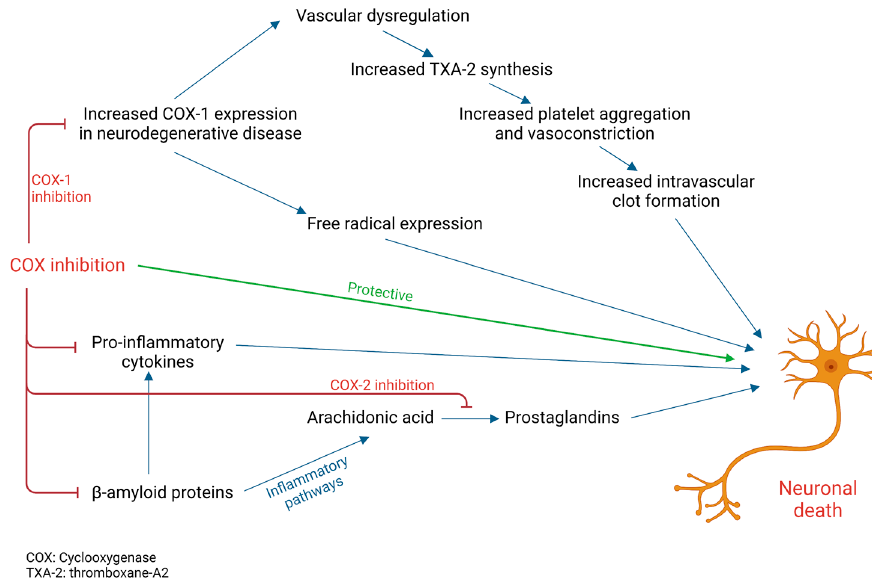
Figure 1. Potential mechanisms of COX inhibition on preventing neural death.